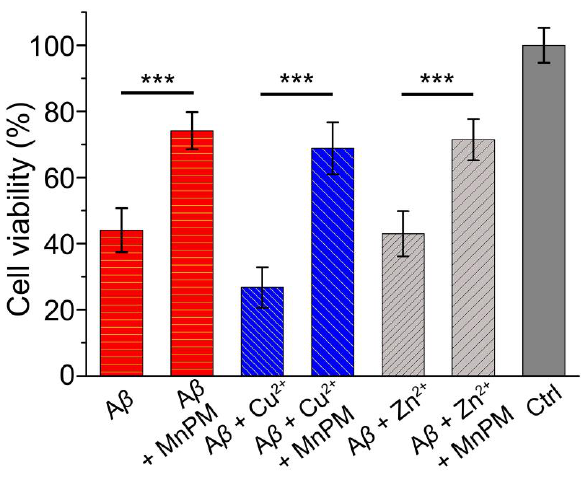
Figure 9. Cell viability of PC12 cells in the presence and absence of A β 40 with or without Cu 2+ or Zn 2+ ions and MnPM determined by MTT assay at 24 h. (A β 40 = 20 µ M, MnPM = 20 µ M, [Cu 2+ ] = [Zn 2+ ] = 40 µ M) (All the samples with final DMSO content: volume ratio 0.5%). The results are obtained from three independent experiments and presented as the mean ± standard deviation of the independent experiments. The results were compared using a two-way ANOVA. *** stands for p ≤ 0.001.